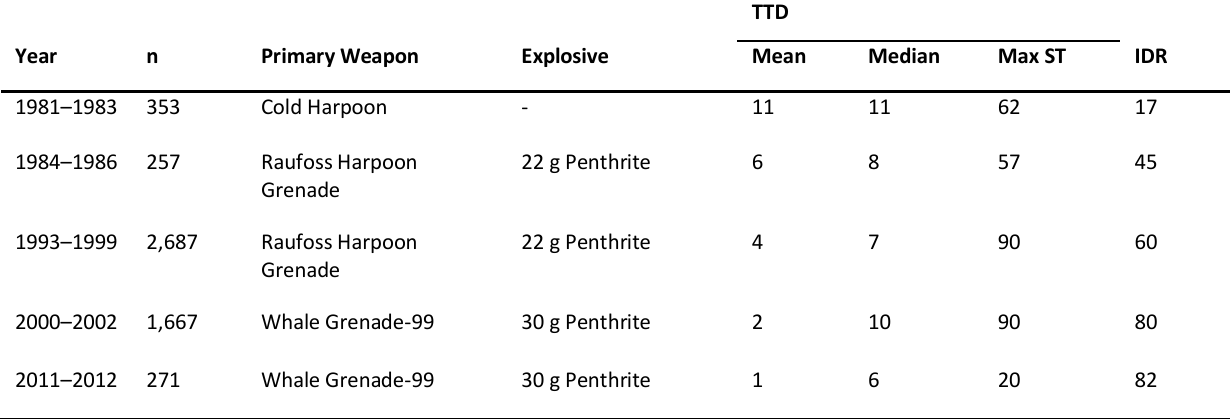
Table 1. Adapted from NAMMCO (2015). Time to death (TTD) expressed as mean, median and maximum survival time (ST) in minutes, and instantaneous death rate (IDR) in percent collected from Norwegian minke whale hunts. Year of trial and number of whales assessed (n) stated with subsequent iteration of primary weapon.